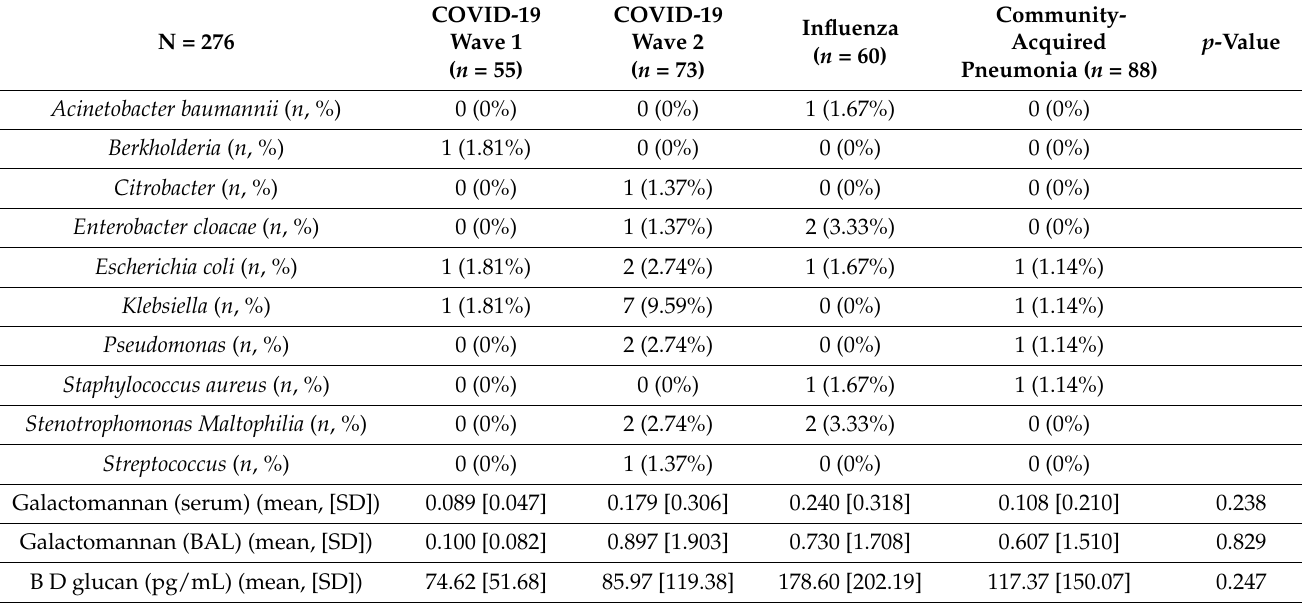
Table 3. Microbiological cultures, galactomannan, and B D glucan